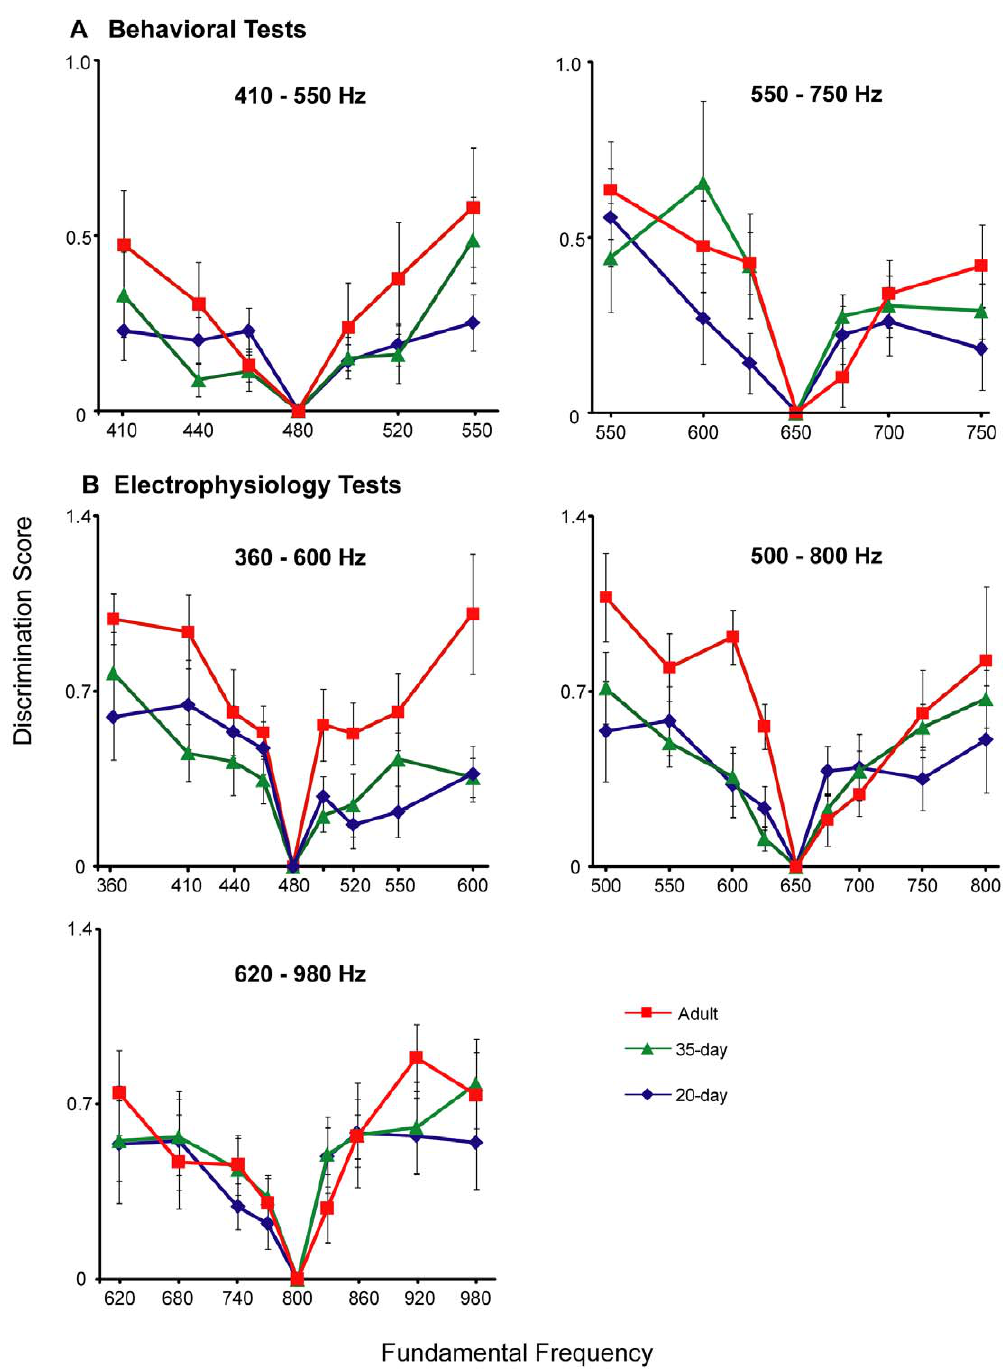
Figure 2. Discrimination gradients depicting ability to distinguish vocal calls for birds of different ages. (A) Behavioral discrimination scores (mean 6 SEM) are plotted for three age groups of birds that were habituated to a call stimulus with a FF of 480 Hz and then tested with novel calls ranging in FF from 410 to 550 Hz (left panel); three separate age groups were habituated to a call stimulus of 650 Hz and tested with novel calls ranging from 550 to 750 Hz (right panel). (B) Neural discrimination scores (mean 6 SEM) for three separate experiments in which different age groups were habituated to call stimuli with a FF of either 480, 650, or 800 Hz and then presented with novel test calls that varied in FF. Discrimination score: 0.0=no different from habituated stimulus, 1.0=completely discriminated; see Methods. doi:10.1371/journal.pone.0052365.g002 scores were significantly different from zero at all steps and all ages discrimination scores of 20-day birds showed mild but non- (one-sample Wilcoxon signed-rank tests, p , 0.001 in all cases). significant improvement from the first to the fourth step (Friedman test, x 2 = 4.9, p =0.18). In contrast, the ability of NCM neurons in The results of the electrophysiological tests showed similar adult birds to discriminate between calls improved substantially: trends to the behavioral experiments (Fig. 3B, right). Neural